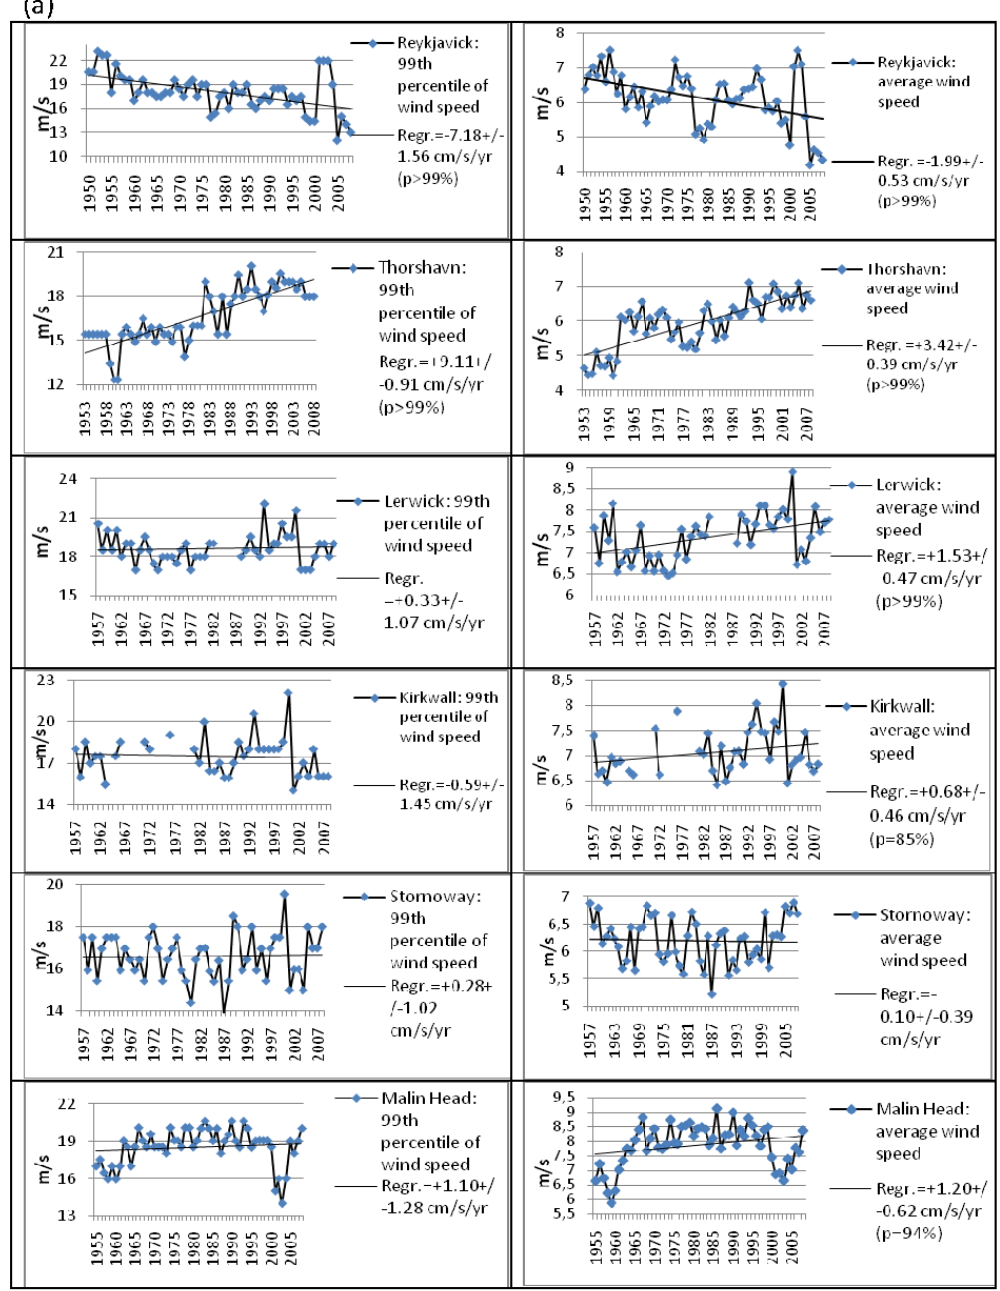
Fig. 4a. Recent changes in extreme (99th percentile) and average wind speed (all directions): (a) at Reykjavick, Thorshavn, Lerwick, Kirkwall, Stornoway and Malin Head; (b) at Belmullet, Shannon, Valentia, Brest, Belle-Ile and Cap